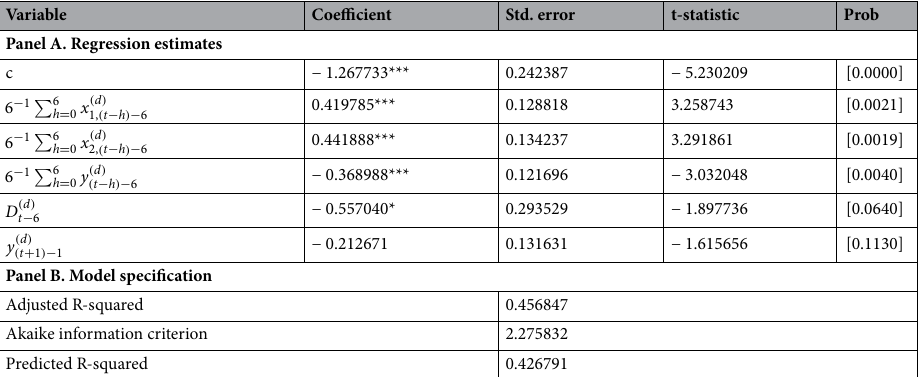
Table 6. Heterogeneous autoregressive model with explanatory variables AR ( 1 ) − H X for daily cases. ***, **, and * denote statistical significance at 1%, 5%, and 10%, respectively. Bootstrapped coefficient estimates and standard errors via 2000 repetitions. The final optimal number of days (w) are selected according to the Akaike information criterion. The variance inflation factor (VIF) is used in order to deal with multicollinearity issues among the regressors. Regressors with values of VIF higher than 5 are excluded from the estimation analysis. The variable is divided by its full-sample standard deviation, estimated based on the basic formula of the variable’s standard deviation. Therefore, the inherent variability of each variable is moved, and all variables have a standard deviation of